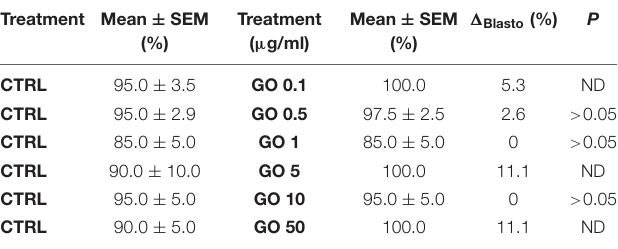
TABLE 3 | Data summarizing the embryo development to the blastocyst stage expressed as differences in percentage ( (cid:49) Blasto %) of embryo development in the CTRL conditions and embryo development of sperms exposed to different concentrations of GO.